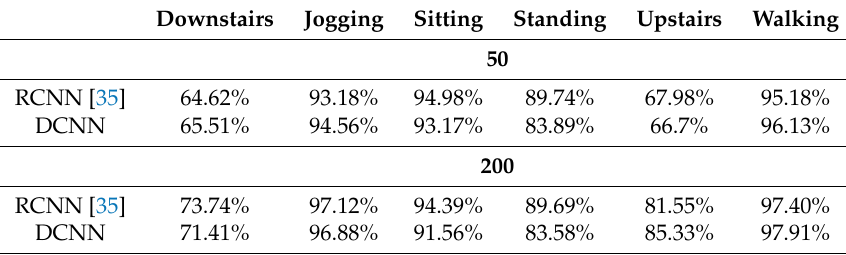
Table A1. Average precision scores of the 10-fold cross-validation of the WISDM dataset.